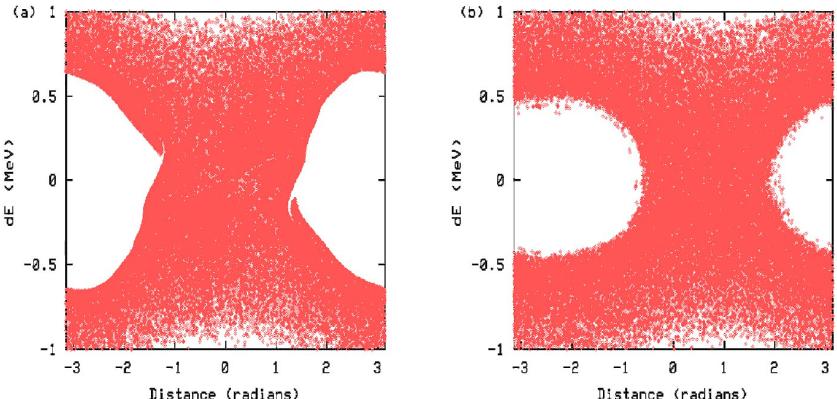
FIG. 9. (Color) (a) Longitudinal phase space of a single microbunch at the end of injection for a 720 nC unchopped beam. (b) Longitudinal phase space of a single microbunch after 10 000 turns of storage for a 720 nC unchopped